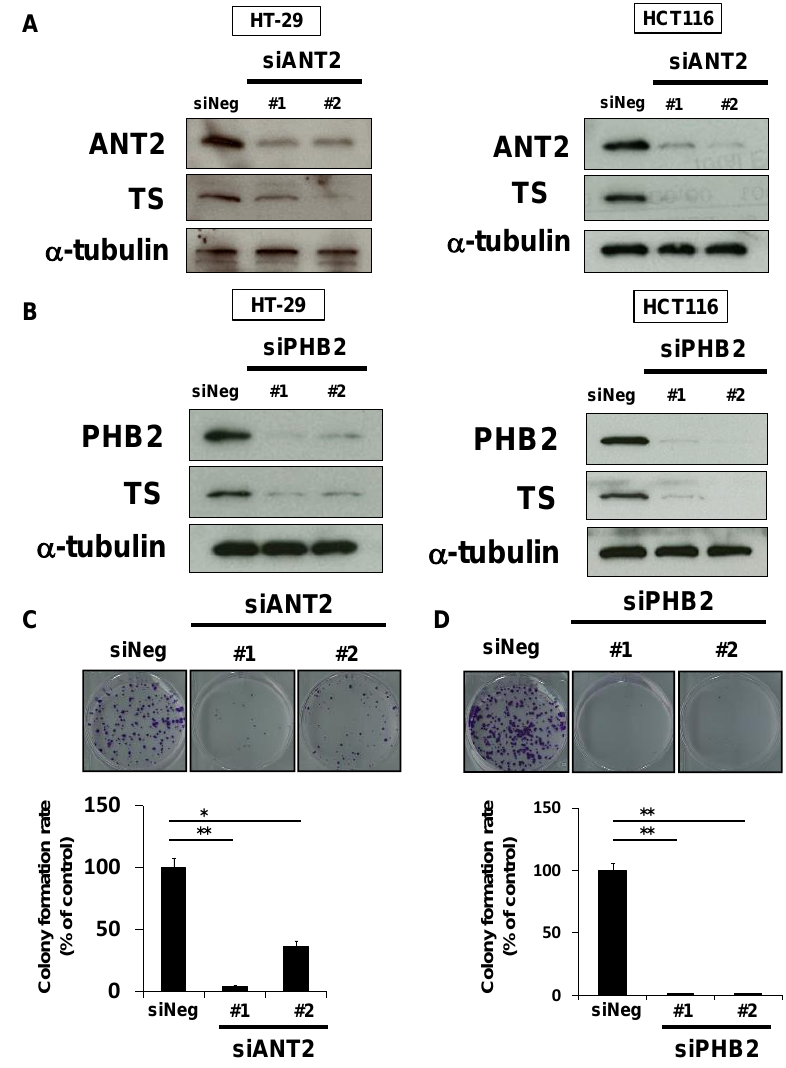
Figure 5. Depletion of ANT2 or PHB2 reduces TS expression and suppresses cell growth. ( A ) Effects of ANT2 depletion on TS protein expression. TS was analyzed by Western blotting in cells treated with siRNAs (#1 and #2) targeting different sequences of ANT2 gene or siNeg for 48 h (HT-29 cells, left panel) or 72 h (HCT116 cells, right panel). α-Tubulin was used as a loading control. ( B ) Effects of PHB2 depletion on TS protein expression. TS was analyzed by Western blotting in cells treated with siRNAs (#1 and #2) targeting different sequences of PHB2 gene or siNeg for 48 h (HT-29 cells, left panel) or 72 h (HCT116 cells, right panel). α-Tubulin was used as a loading control. ( C ) Effects of ANT2 depletion on colony formation. HT-29 cells were treated with siANT2 or siNeg. After further incubation, colonies were fixed and stained with crystal violet. The representative images of stained colonies are shown (upper panel). Colony formation rates are shown in the graph (lower panel). Columns, means ( n = 3); bars, SD, * p <0.05, ** p <0.01, significantly different from the siNeg-treated control. ( D ) Effects of PHB2 depletion on colony formation. HT-29 cells were treated with siPHB2 or siNeg. After further incubation, colonies were fixed and stained by crystal violet. The representative images of stained colonies are shown (upper panel). Colony formation rates are shown in the graph (lower panel). Columns, means ( n = 3); bars, SD, ** p <0.01, significantly different from the siNeg-treated control.